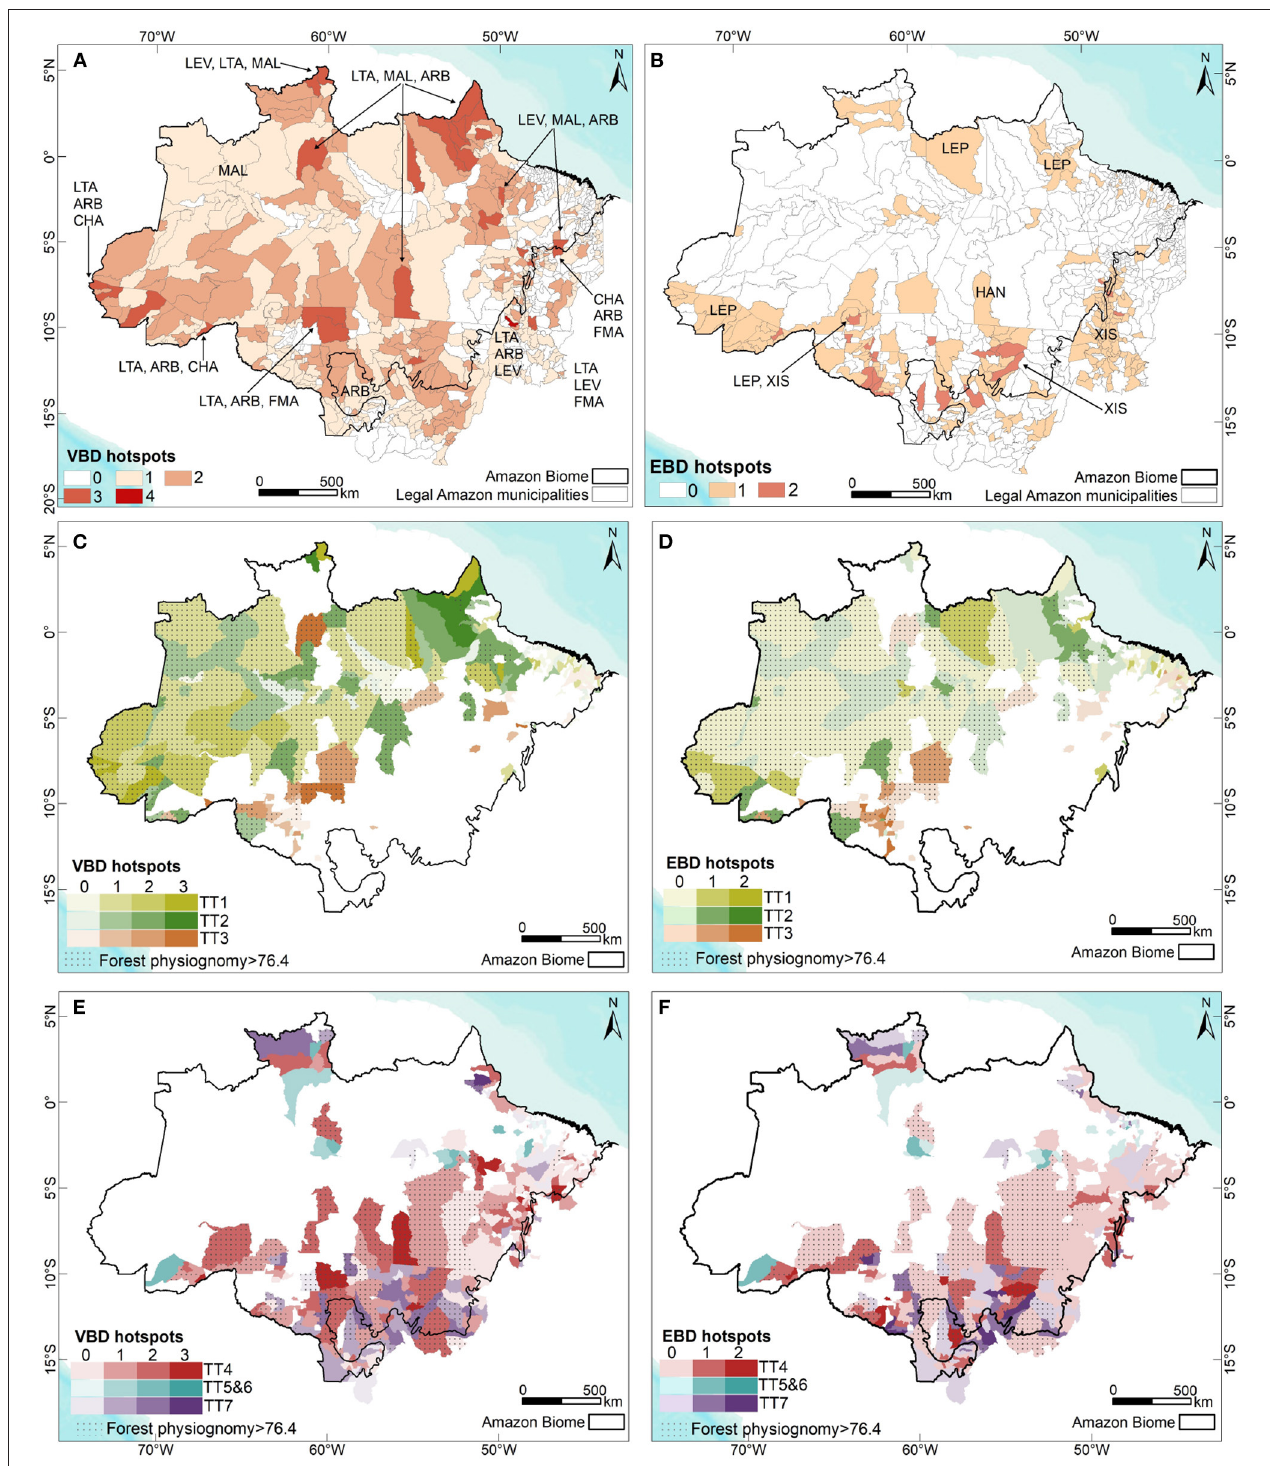
FIGURE 2 | (A) Municipalities presenting the occurrence and co-occurrence of Vector-borne diseases (VBD); (B) Municipalities presenting the occurrence and co-occurrence of schistosomiasis, hantavirosis and leptospirosis (EBD); Municipalities dominated by Peasant Trajectories (colors), forest physiognomy (hatch) and the occurrence of VBD (C) or EBD (D) (color intensity); Municipalities dominated by Farmer and Rancher Trajectories (colors), forest physiognomy and occurrence of VBD (E) or (F) EBD (color intensity).